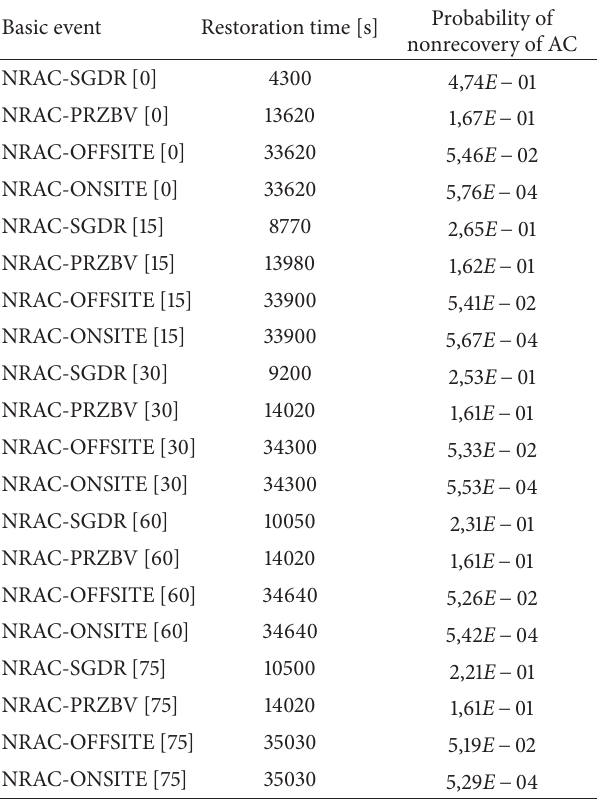
Figure 7: Pressurizer pressure, SBOS4 case scenarios.